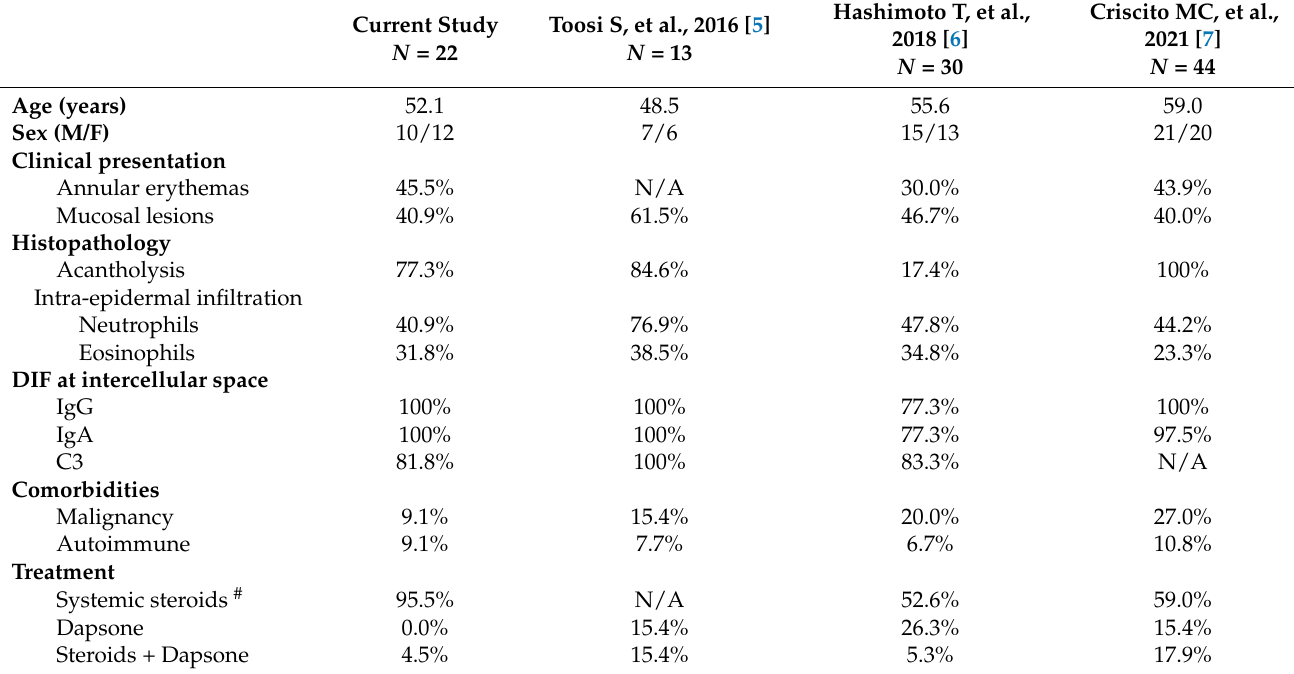
Table 3. Comparison of case series of IgG/IgA